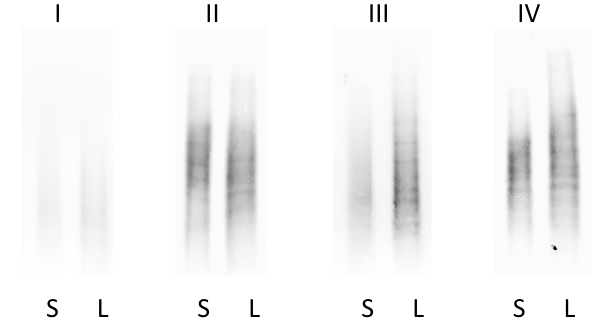
Figure 2. Detection of OGIgAB in paired CSF and serum samples from 4 MS patients. Representative blottings of individuals showing Pattern 1 (I), Pattern 2 (II), Pattern 3 (III) and Pattern 4 (IV). S: serum. L: cerebrospinal fluid.